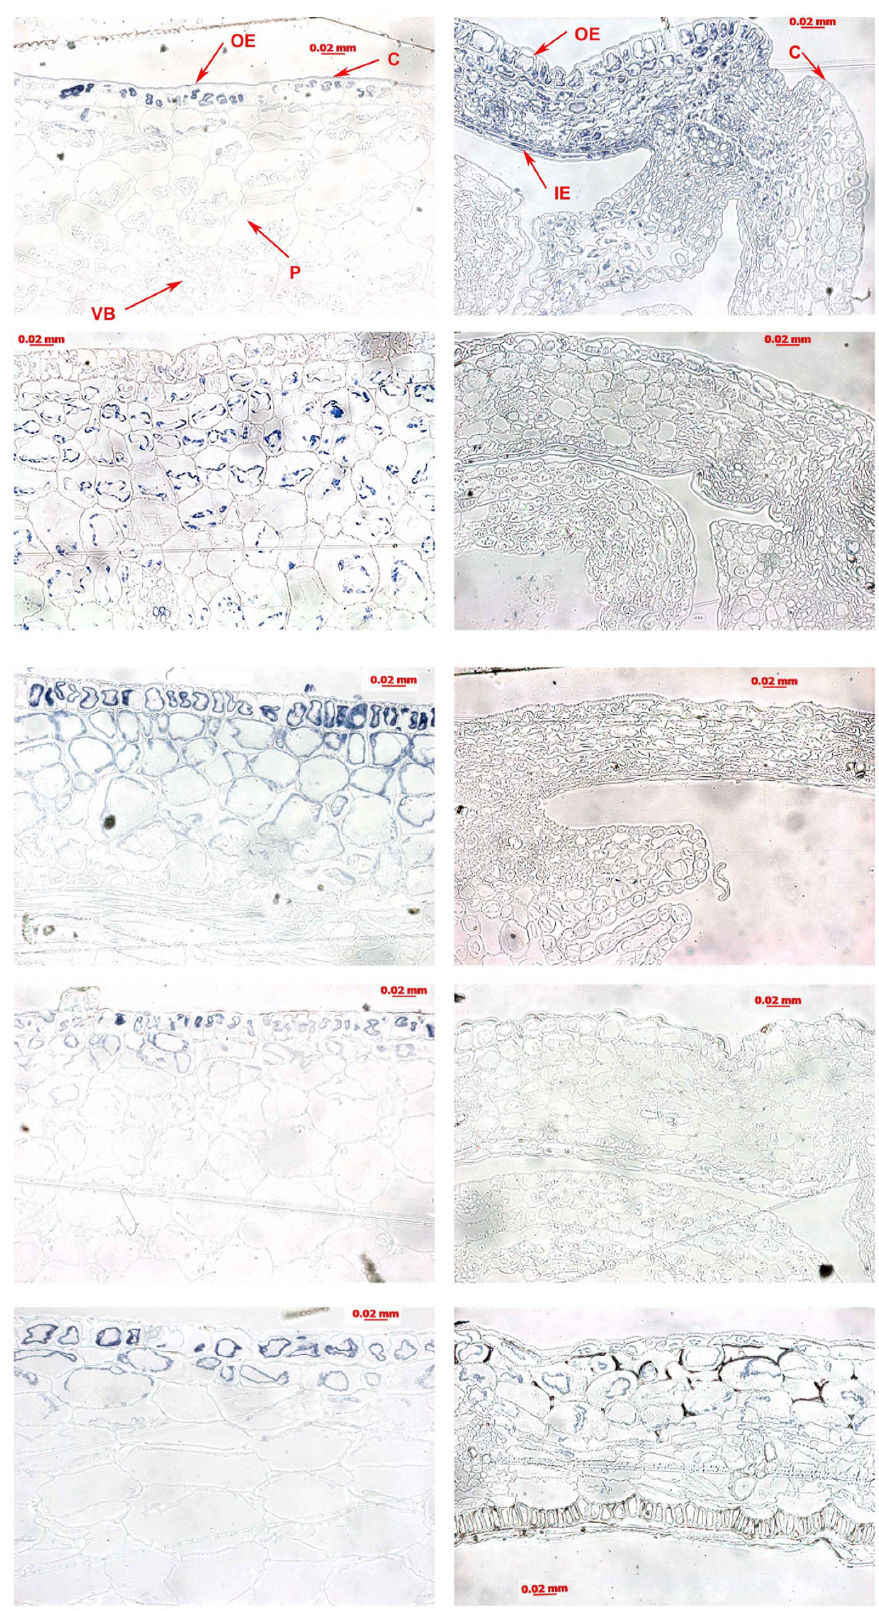
Figure 2. Structural features and thickness of pod walls. Structures of P. sativum (left column) and B. chinensis (right column) in pods at each developmental stage (from top to down) were detected by light micrographs. Each panel represents microscopic observations of one transverse